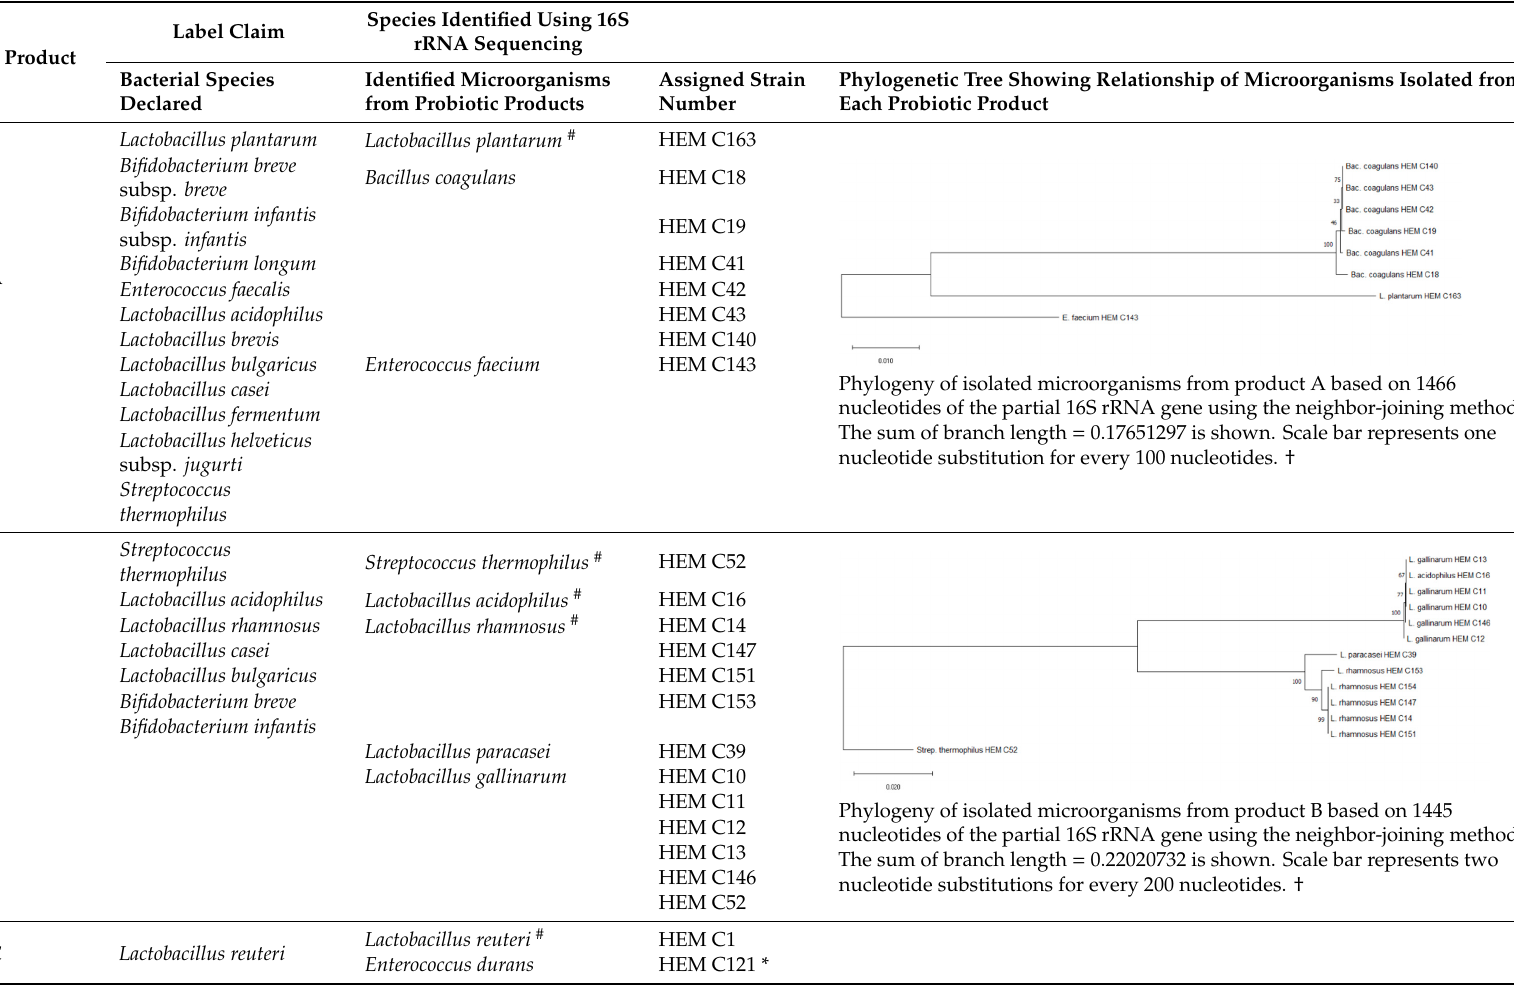
Table 1. Microorganisms listed on the label claims of probiotic products for children compared to those recovered and identified based on culture-dependent identification (16S rRNA sequencing).